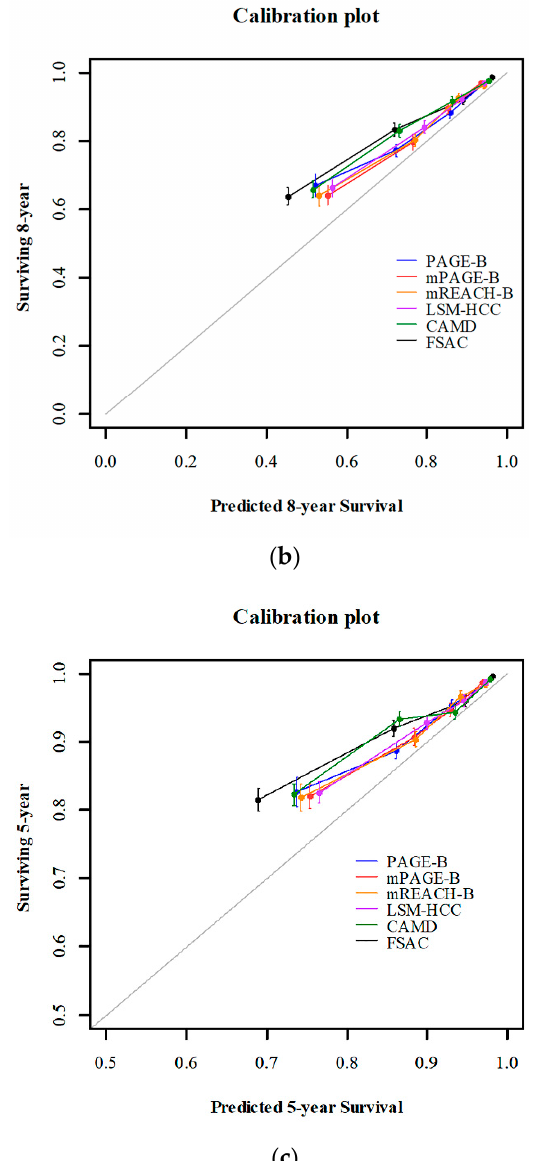
Figure 2. Calibration plots for FSAC and other risk prediction models for development of hepatocellular carcinoma at 3 ( a ), 5 ( b ), and 8 years ( c ) after initiating AVT. HCC, hepatocellular carcinoma; CHB, chronic hepatitis B; AVT, antiviral therapy.